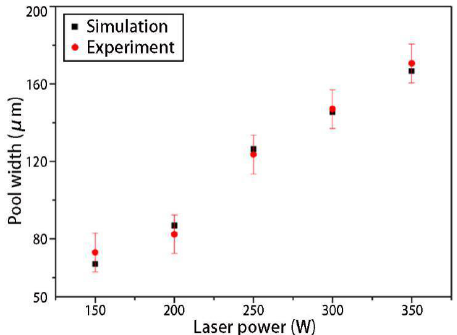
Figure 13. Simulation results of the final shapes of solidified tracks under different laser powers: ( a ) 150 W; ( b ) 200 W; ( c ) 250 W; ( d ) 300 W; ( e ) 350 W.